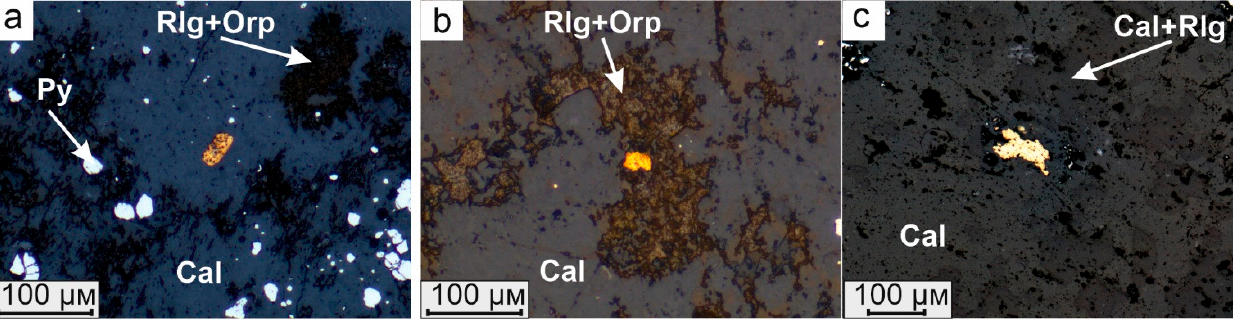
Figure 8. BSE-photo of the morphology of native gold grains and aggregates from breccias with orpiment-realgar cement (explained in the text). ( a ) gold crystal; ( b ) gold with mineral inclusions of calcite (Cal), pyrite (Py) and realgar (Rlg); ( c ) native gold intergrows with pyrite; ( d ) native gold intergrows with realgar; ( e ) native gold intergrows with calcite; ( f ) pyrite crystals in native gold. Native gold contains numerous mineral inclusions. Small crystals of pyrite, prehnite, quartz and calcite are directly enclosed in the native gold. Polymineral inclusions, consist- ing of calcite, barite and dalnegroite, are found in gold aggregates as well (Figure 9a). Polymineral inclusions formed by prehnite, barite and routhierite are also detected (Fig- ure 9b). Hyalophane grains are present as inclusions in gold in a very limited quantity. The above-listed minerals can be found not only in the form of inclusions in gold but also as intergrowths with gold. Among the rare minerals intergrown with gold, we also note coloradoite, arsenolite (Figure 9c) and parapierrotite (Figure 9d). Arsenolite is the most recent mineral formed as a result of supergene processes.